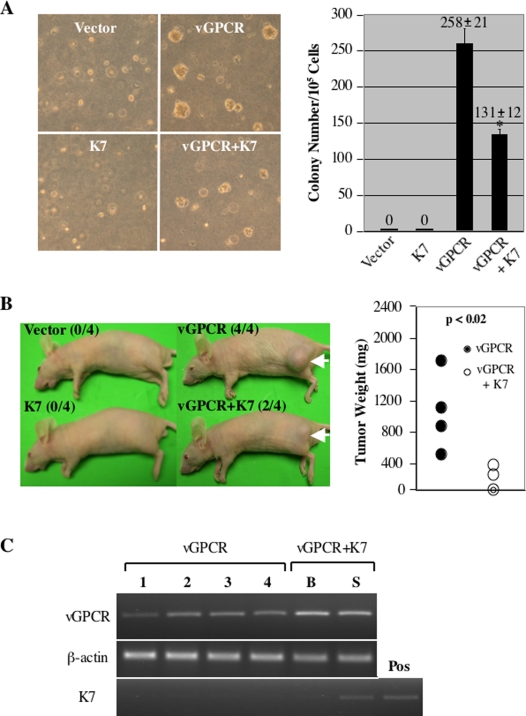
K7 negatively regulates vGPCR tumorigenicity.(A) K7 reduces vGPCR activity to stimulate anchorage-independent growth of NIH3T3 cells. Colonies under microscope were photographed (left panels, 4×) or counted (right graph) after a 2-wk incubation. Data represent 3 independent experiments. Error bars denote standard deviation; *p<0.02 relative to NIH3T3/vGPCR cells as calculated by Student's t-test. (B) K7 reduces vGPCR tumorigenicity in nude mice. Cells were injected into nude mice subcutaneously, and mice were killed and photographed (left panel) 6 wk later. Tumor weight was measured (right graph). The numbers in parenthesis indicate the number of mice developed tumor among 4 tested animals. Arrows indicate location of tumor and data represent 4 independent measurements for each group. (C) vGPCR and K7 expression in tumors. RT-PCR analyses were performed as described in Materials and Methods using primers specific for vGPCR, K7, and cellular β-actin. PCR products resolved on agarose gel were photographed. B, the bigger tumor; S, the smaller tumor; Pos, a positive control of K7.